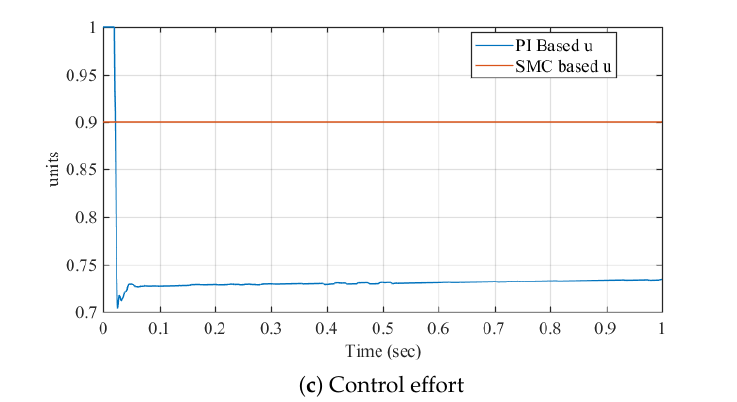
Figure 8. Case 1: Power flow from DC to AC side